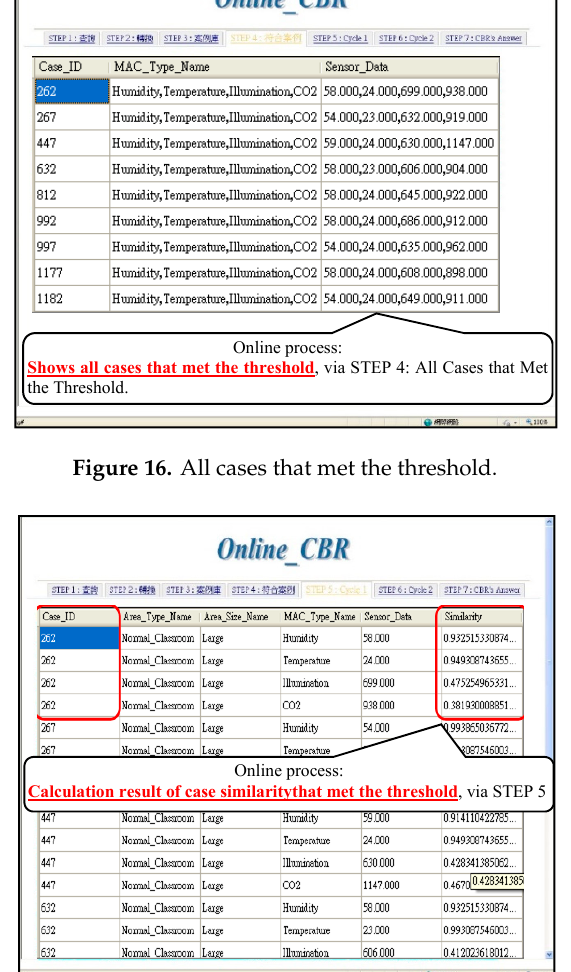
Figure 17. Calculation result of case similarity.